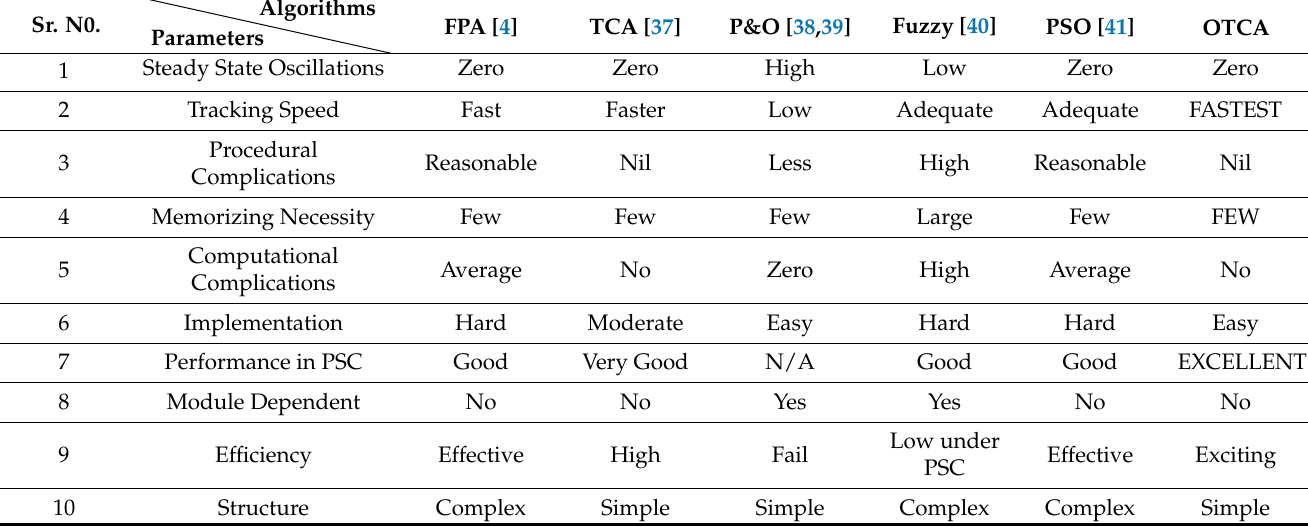
Table 12. Performance assessment of OTCA compared to leading MPPT algorithms. Sr.